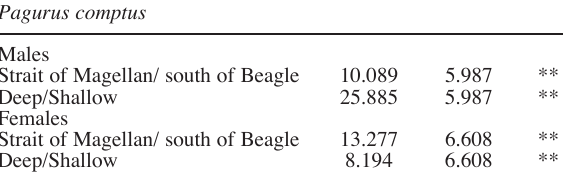
T ABLE 5. – Table (Ftab) and calculated (Fcalc) values from variance analysis (ANOVA) for carapace length (CL mm) comparing the Strait of Magellan (SM) with the area south of the Beagle Channel (SB), and different depths (depth limit shallow/deeper at 75 m). (**) Significant difference (p > 0.05); ns: not significant (p < 0.05). Eurypodius latreillii F calc. F crit. Males Strait of Magellan/ south of